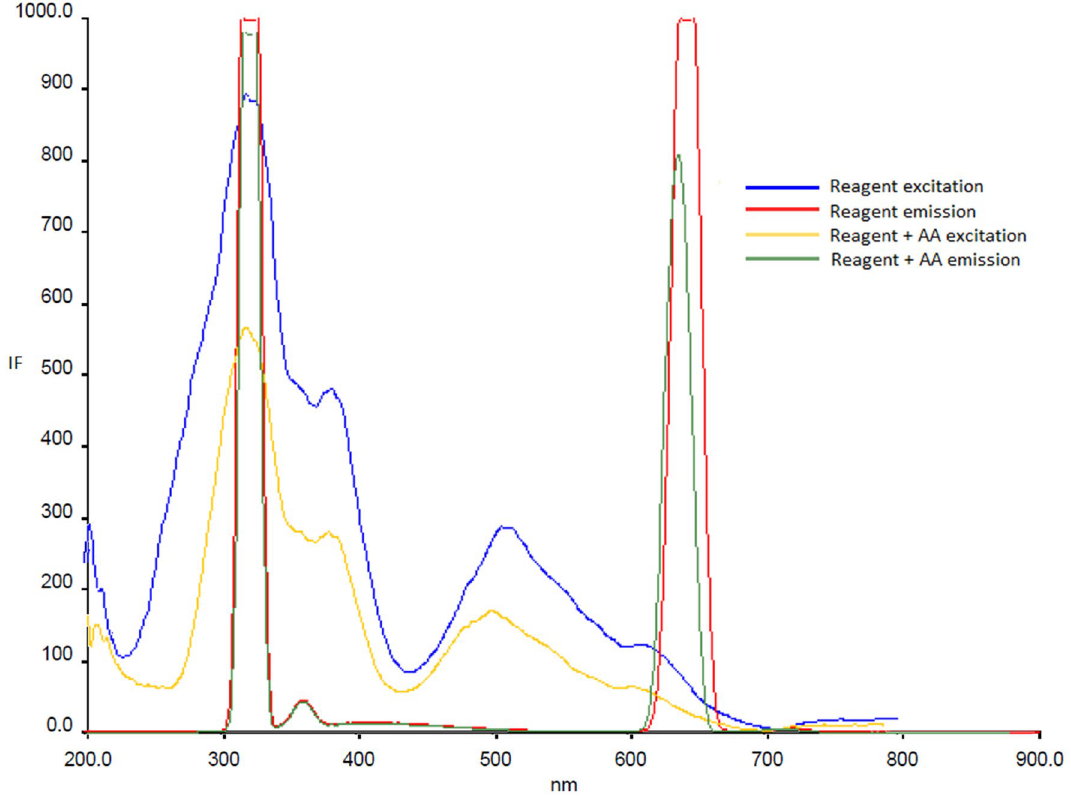
Fig. 2 Excitation and emission spectra of the reagent (phosphate buffer/BCP) without AA and with added